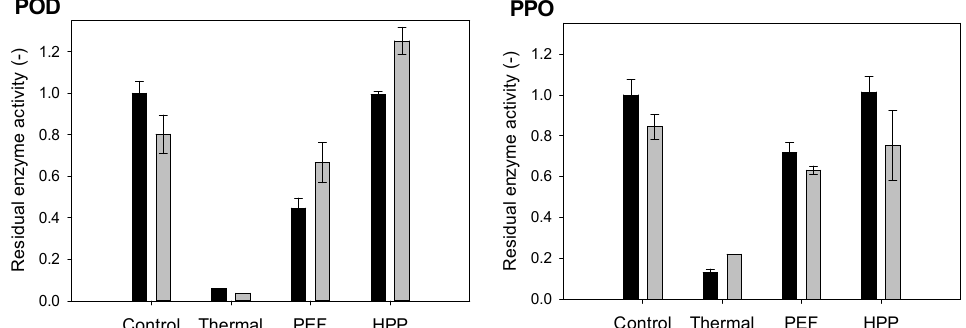
Antioxidants 2021 , 10 , x FOR PEER REVIEW Figure 2. Residual enzyme activity of peroxidase (POD) and polyphenoloxidase (PPO) in the strawberry-kale mix (compared to the untreated sample before storage) immediately after the treatment (black) and after storage (grey).